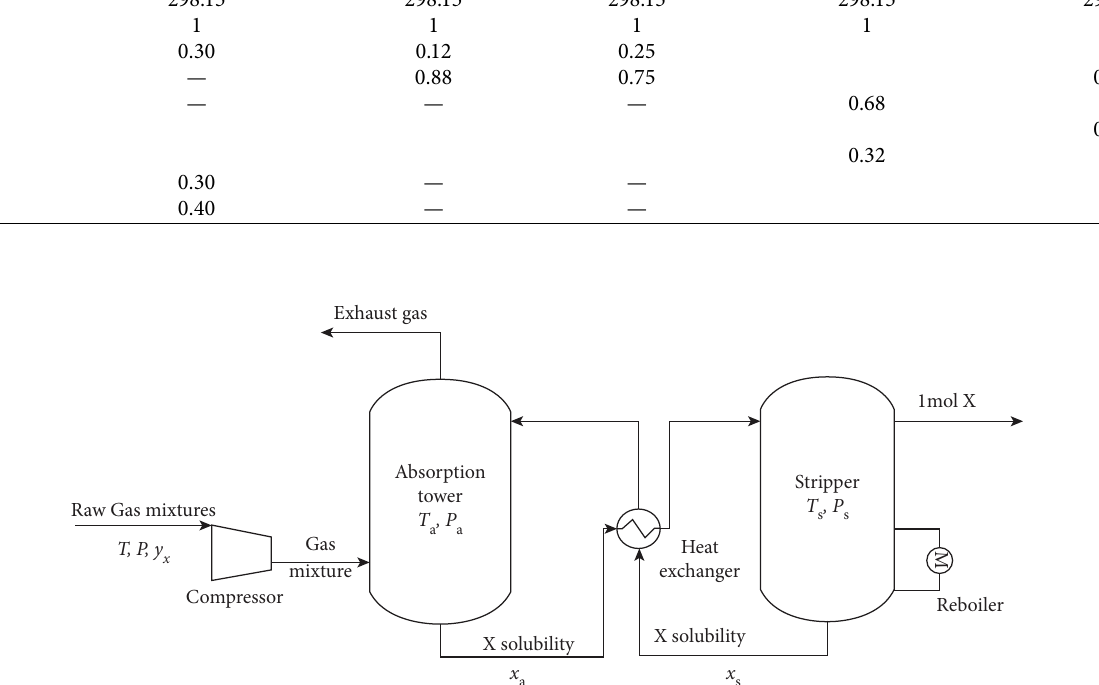
Figure 1: Reduced engineering fow sheet for gas separation process.